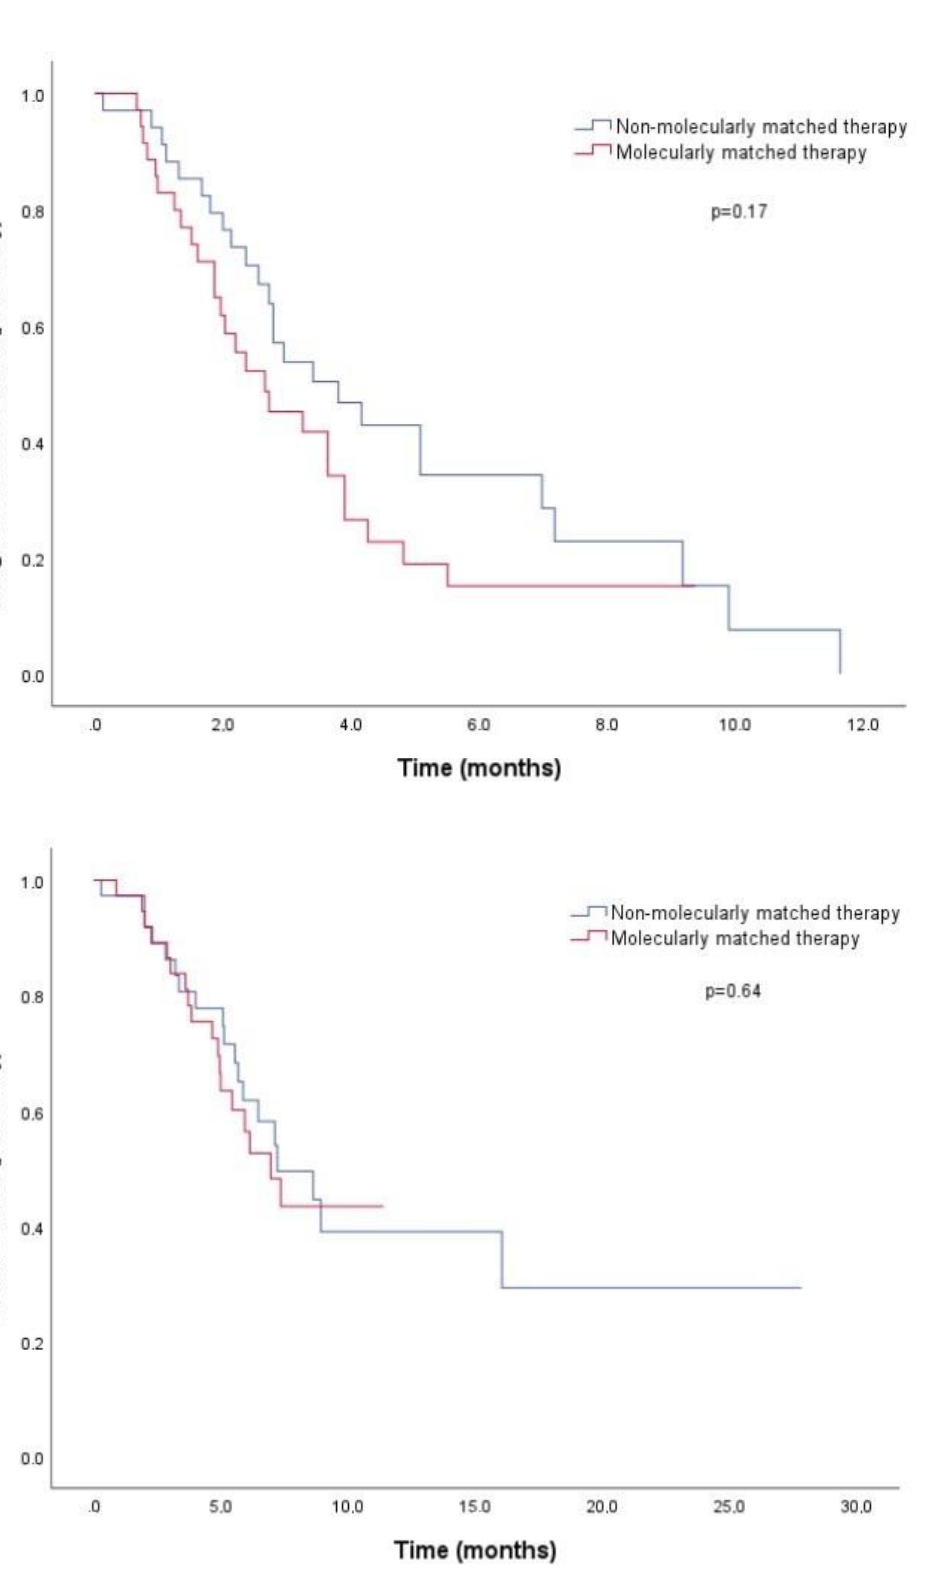
Figure 4. Kaplan–Meier curves of progression-free survival (PFS2) ( A ) and overall survival ( B ) in patients with actionable molecular alterations treated with “molecularly matched therapy” or “non-molecularly matched therapy”.